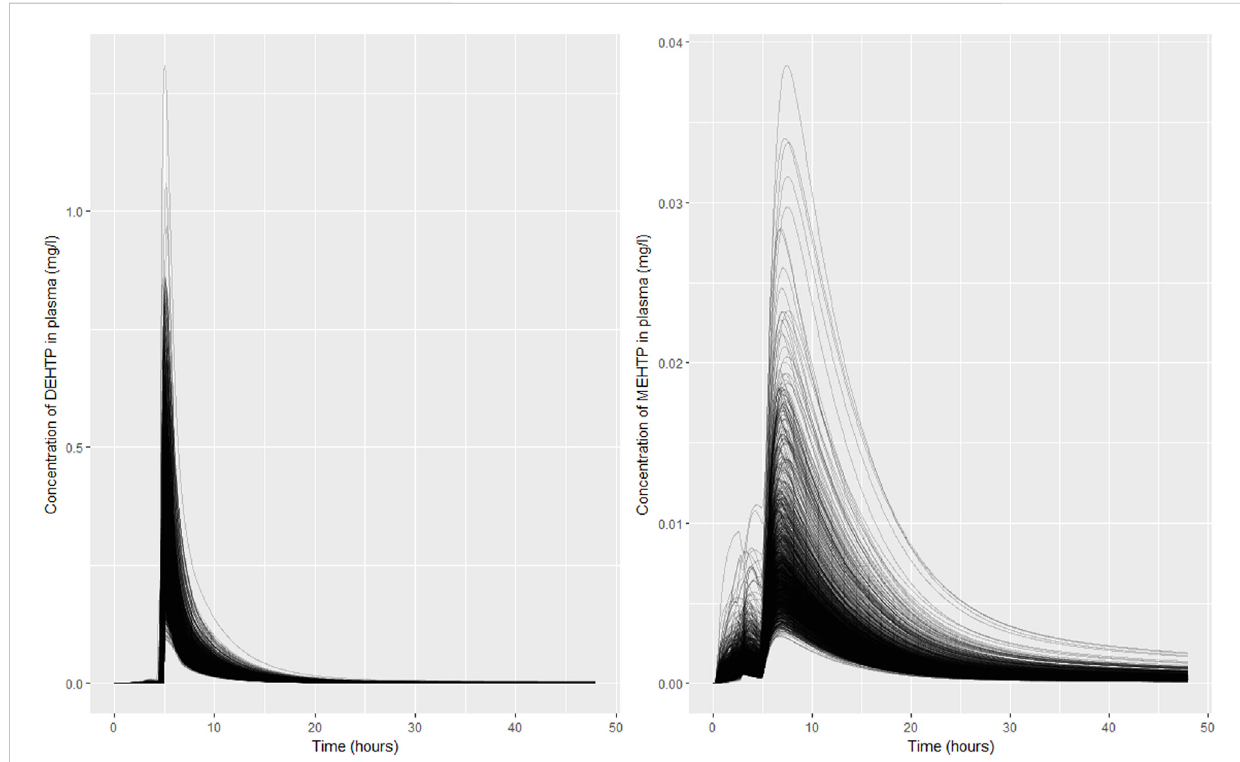
FIGURE 7 Simulatedconcentrationsof (A) DEHTPinbloodand (B) MEHTPinthebloodofindividual (B) .Individualcurvescorrespondtotheretainedparameter sets from the posterior